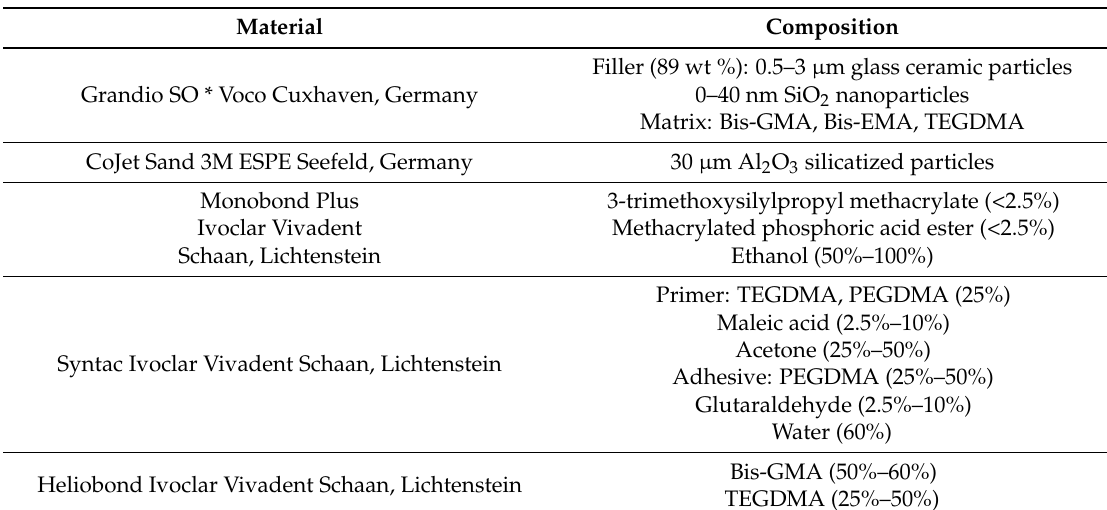
Table 3. Materials used (information supplied by the